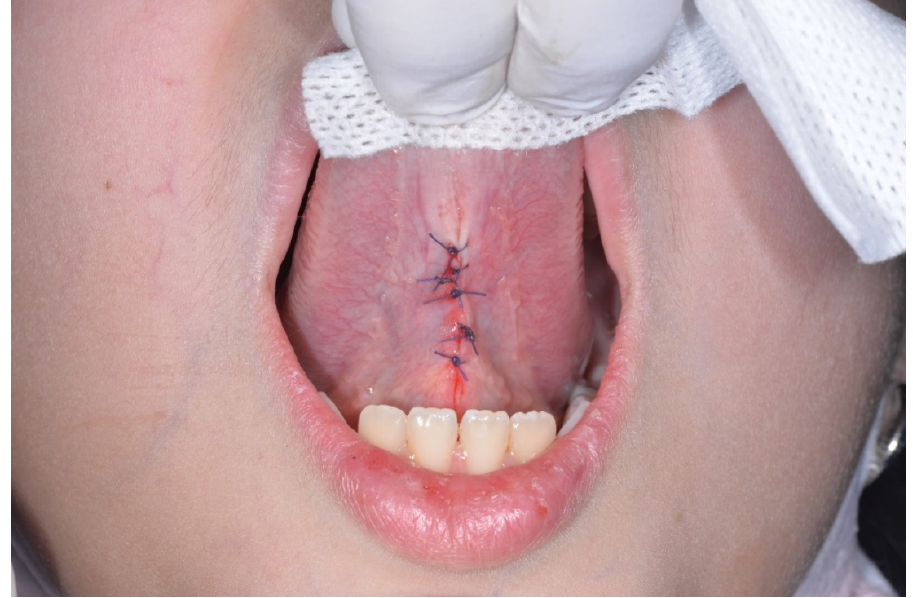
Figure 5. Result after suturing.